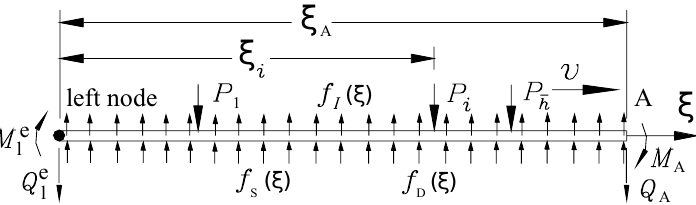
e e , f S ( ξ ) = k w Nq , and